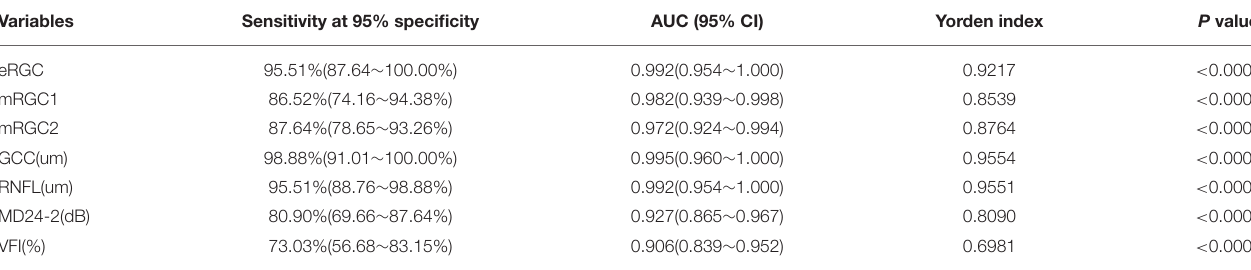
TABLE 2 | Diagnostic efficacy and sensitivity analysis of eRGC, mRGC1, and mRGC2 and related structural/functional parameters.